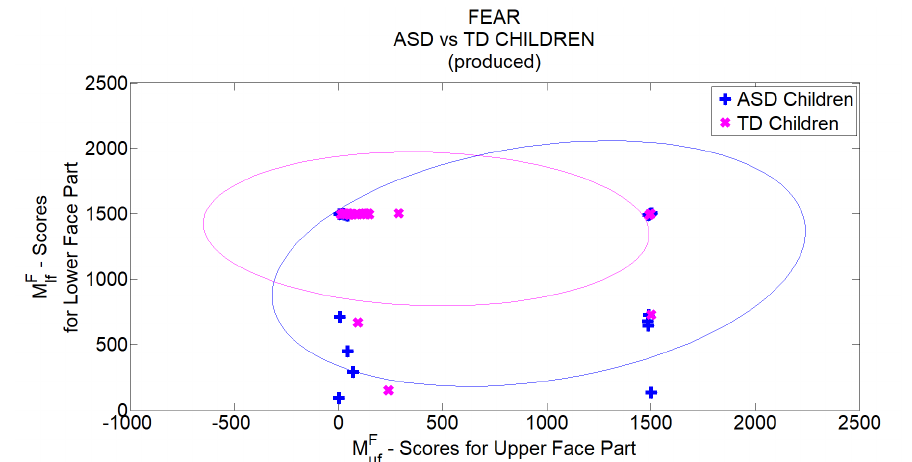
Figure 15. Comparison of the scores computed for the production of Fear expressions by ASD and TD children.